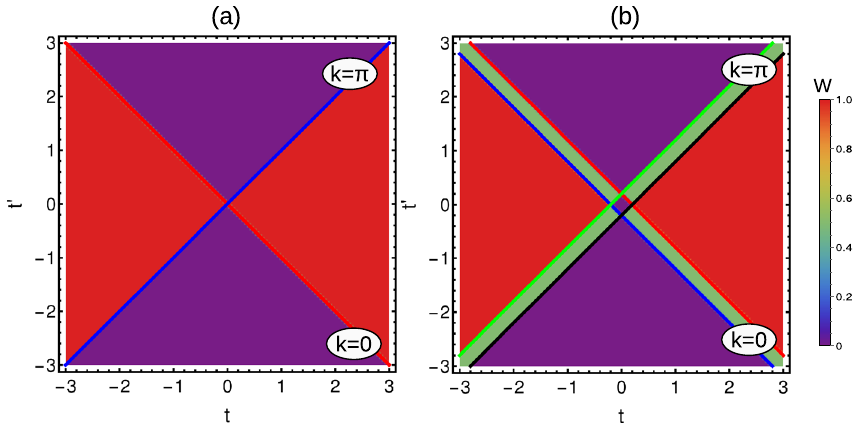
Figure 2. (Color online) Phase diagram of short-range SSH chain with periodic boundary condition ( a ) Hermitian case ( b ) Non-Hermitian case. In Hermitian case, we obtain only integer topological phases, whereas in non-Hermitian case, we obtain fractional phases along with integer topological phases.